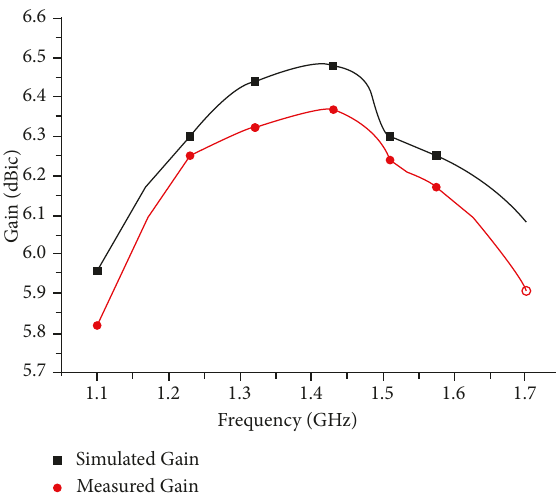
Figure 11: Simulated and measured gain of the